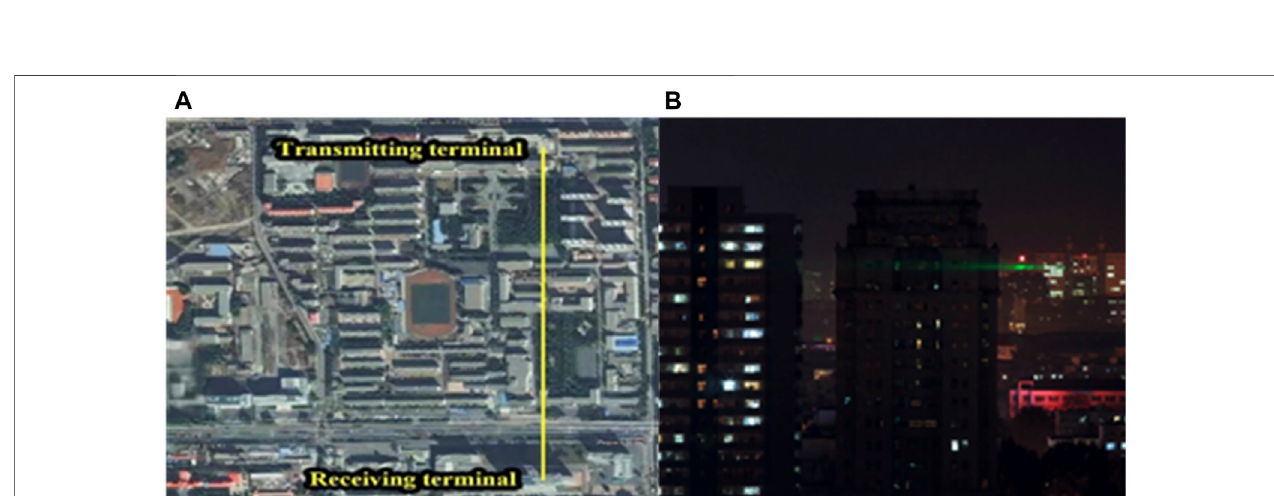
FIGURE 6 | (A) Distance between fi eld test sites is 1 km; (B) experimental scene light path